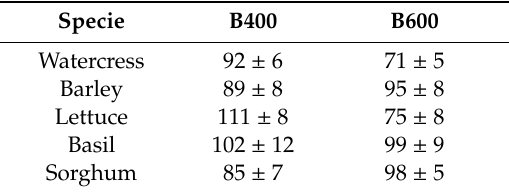
Table 4. Germination index and standard deviation for di ff erent species and two pyrolysis temperatures of biochar (400 ◦ C—B400 and 600 ◦